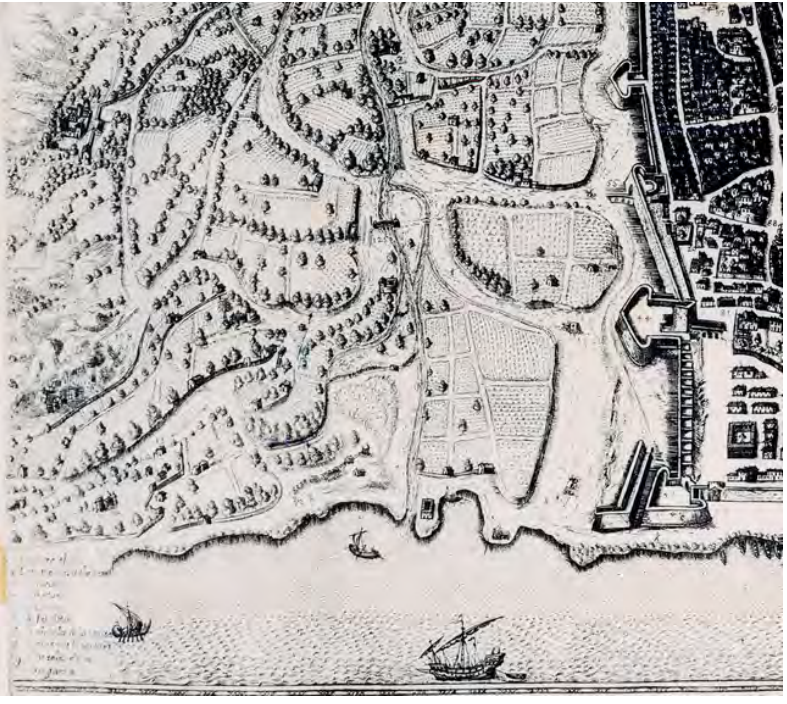
Figure 3. The Arcs of Saint